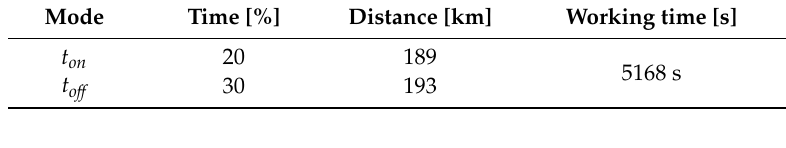
Table 10. Optimal on-off control mode in the last cycle.